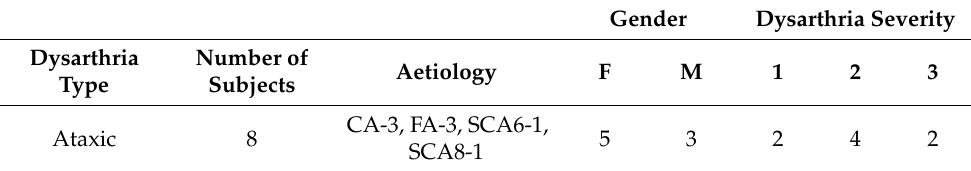
Table 2. Characteristics of the selected English